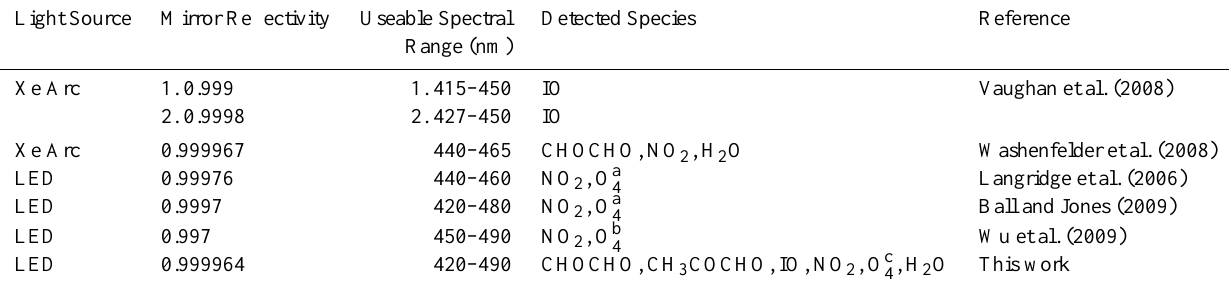
Table 1. Previous CEAS instruments in the blue spectral